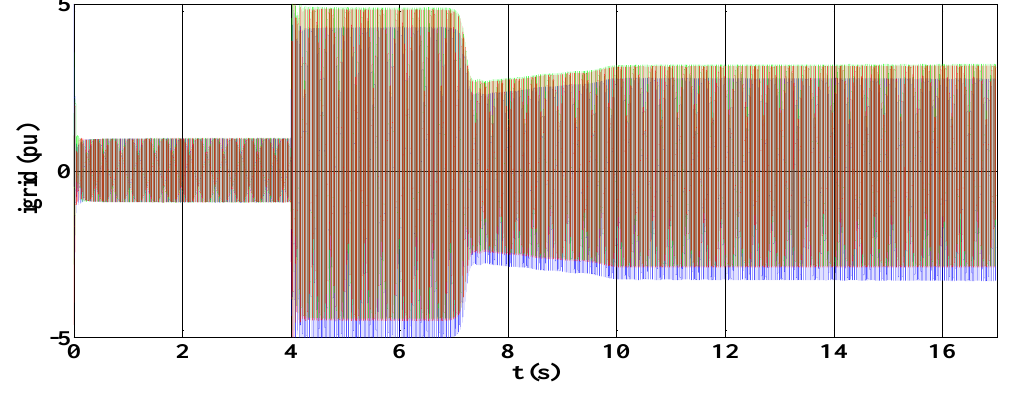
Figure 21. Grid Side Converter (GSC) phase currents I gabc (short-circuit happens at t = 4 s).